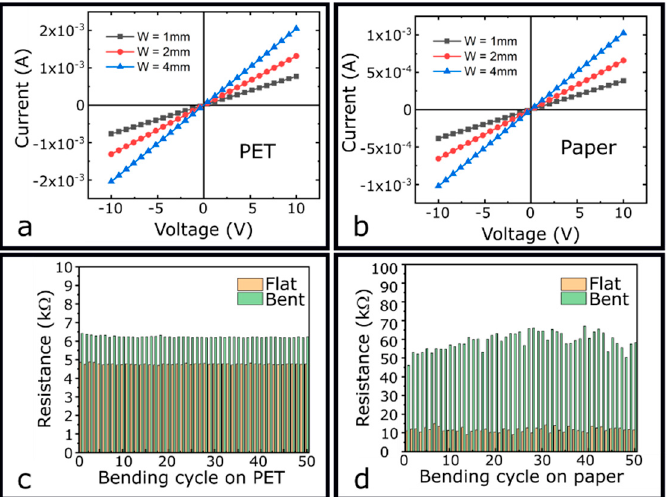
Figure 2. Electrical behaviour of the CB ink printed resistors under strain. Current versus voltage plots on ( a ) plastic and ( b ) paper substrates. Measured resistances during 50 bending cycles of the inkjet-printed CB line (W = 4 mm) in flat and bent positions for the ( c ) plastic and ( d ) paper substrates. Bending radius was kept constant at 4 mm.